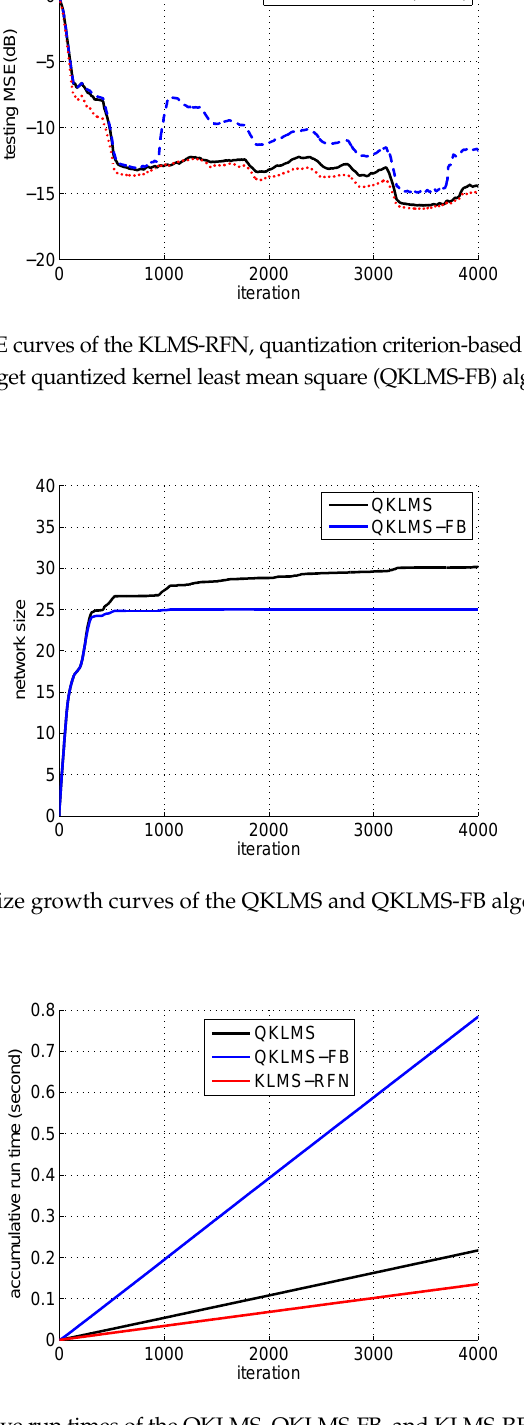
Figure 6. The accumulative run times of the QKLMS, QKLMS-FB, and KLMS-RFN algorithms for Lorenz time series